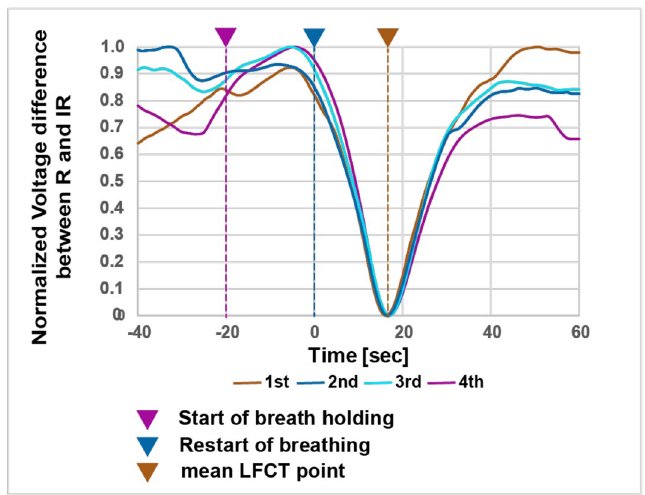
Figure 4. The representative patient data. Four LFCT curves were overwritten. We normalized the voltage difference to make each LFCT value clear in this figure. We calculated the maximum difference between R and IR to 1 and minimum to 0 in each session. The patient was measured LFCT for 4-times. There were clear singular nadirs in LFCT curves. Each LFCT value was 16.14, 16.50, 16.96, and 16.76 (seconds), respectively. This case showed high reproducibility of LFCT. LFCT: lung to finger circulation time, R: red light, IR: infrared light.